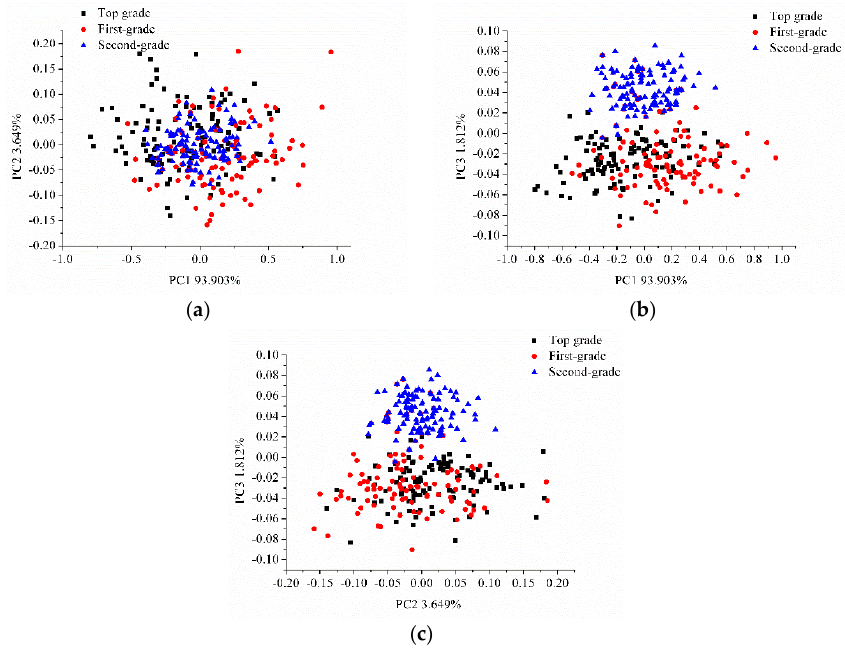
Figure 4. Score scatter plots of ( a ) PC1 vs. PC2, ( b ) PC1 vs. PC3, and ( c ) PC2 vs. PC3 for sliced sausages.